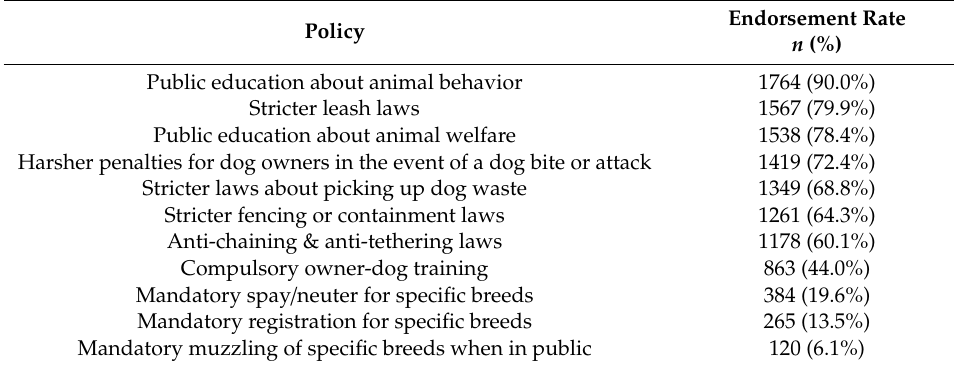
Table 9. Veterinarians’ reported endorsement of community policies enacted in e ff orts to increase public